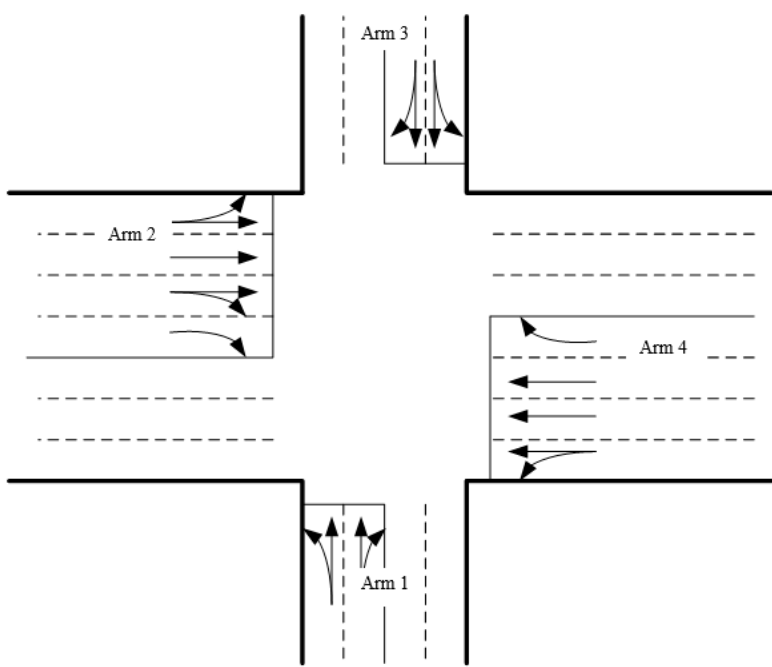
Figure 6. Optimized lane marking patterns for the case study intersection.